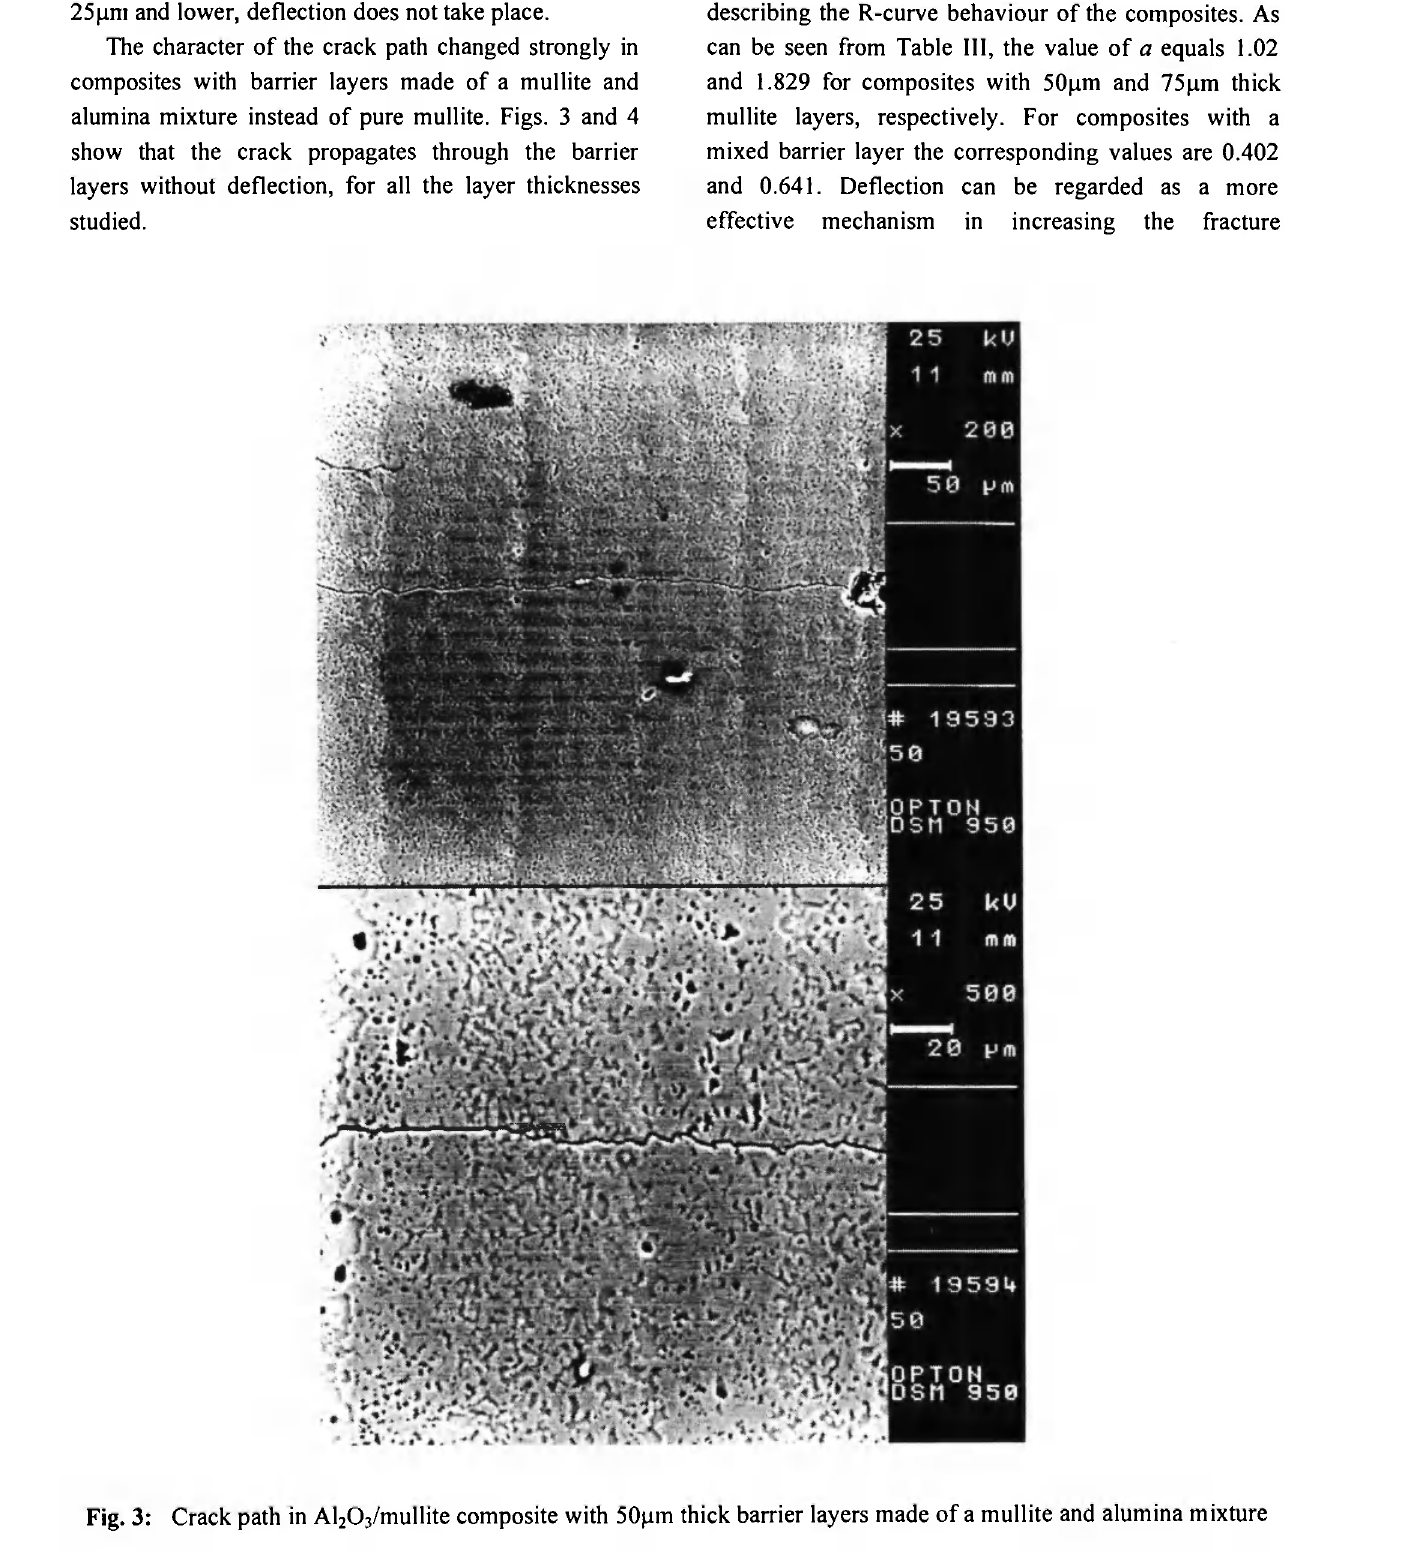
Fig. 3: Crack path in Al 2 0 3 /mullite composite with 50μιη thick barrier layers made of a mullite and alumina